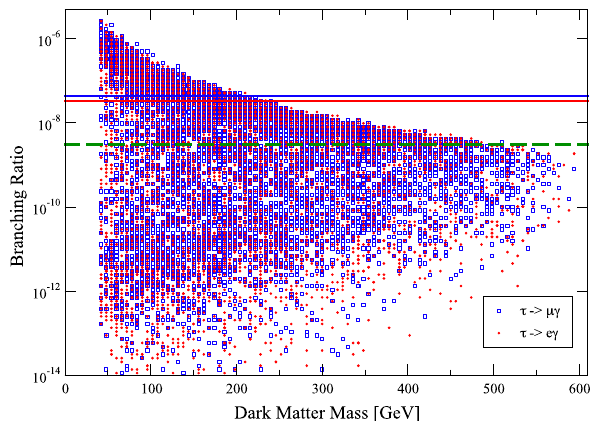
Fig. 6 The branching ratios τ → μγ (blue squares) and τ → e γ (red stars) as a function of the dark matter mass for our sample of viable models. The solid lines show the current bound for each process while the dashed line corresponds to the expected future sensitivity